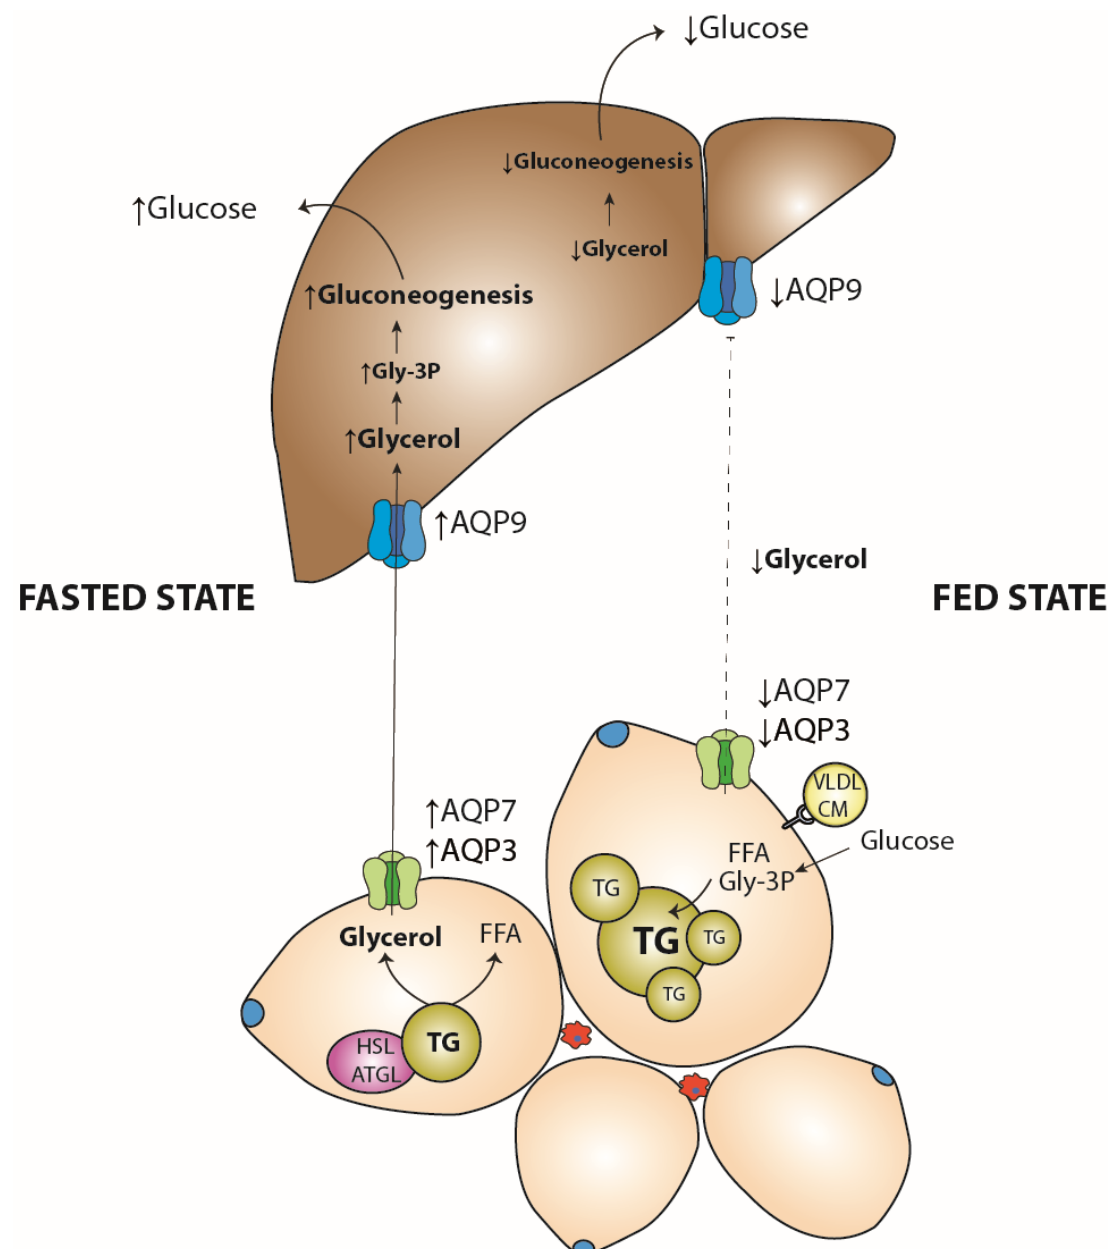
Figure 1. Regulation of adipose tissue aquaporins (AQPs), AQP3/AQP7, and liver AQP9 during fasting and feeding states. Fasting induces lipolysis in adipocytes, and gluconeogenesis in liver (as depicted on the left side of the figure); AQP7 and AQP3 messenger RNA (mRNA) levels are elevated in adipose tissue (AT), facilitating glycerol release into the blood stream. In turn, AQP9 mRNA levels in liver are also increased in order to transport glycerol in the portal vein. In the liver, glycerol is transformed into glycerol 3 ‐ phosphate (Gly ‐ 3P), and used as a substrate for gluconeogenesis, increasing glucose levels in the blood. In the fed state, the abundance of nutrients triggers a metabolic switch from lipolysis to lipogenesis in adipocytes, suppressing glucose production in the liver. Thus, adipose AQP3 and AQP7 mRNA levels decrease, and free fatty acids (FFA) are stored in the form of triglycerides (TGs). Circulating glycerol levels also decrease in parallel with the reduction in adipose AQP ‐ mediated glycerol shuttling, and liver AQP9 levels. HSL—hormone ‐ sensitive lipase; ATGL—adipose triglyceride lipase; VLDL—very low ‐ density lipoprotein; and CM—chylomicrons. Increased ( ↑ ) decreased ( ↓ ).